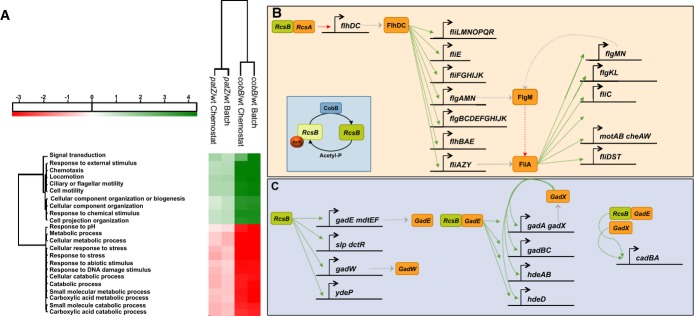
Microarray analysis of transcriptional response to cobB and
patZ deletions in E. coli in batch and chemostat glucose
culturesA Annotation matrix obtained from the gene expression microarray data where the main functions of
the up- and down-regulated genes are grouped by their expression with a P-value
threshold of 0.005; for further information see Geiger et al (2013). Gene expression data were referred to the wild-type strain and expressed as
fold-change.B, C Transcriptional regulation of the flagellar regulon (B) and acid stress response genes (C)
by RcsB (Keseler et al, 2013).Source data are available online for this figure.